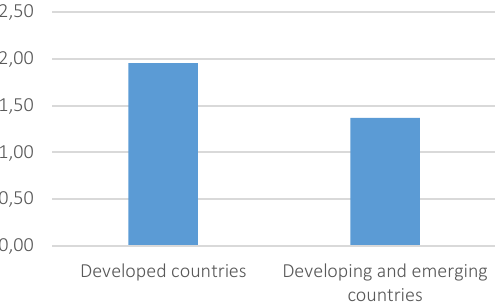
Figure B3. Government corporate ESG disclosure